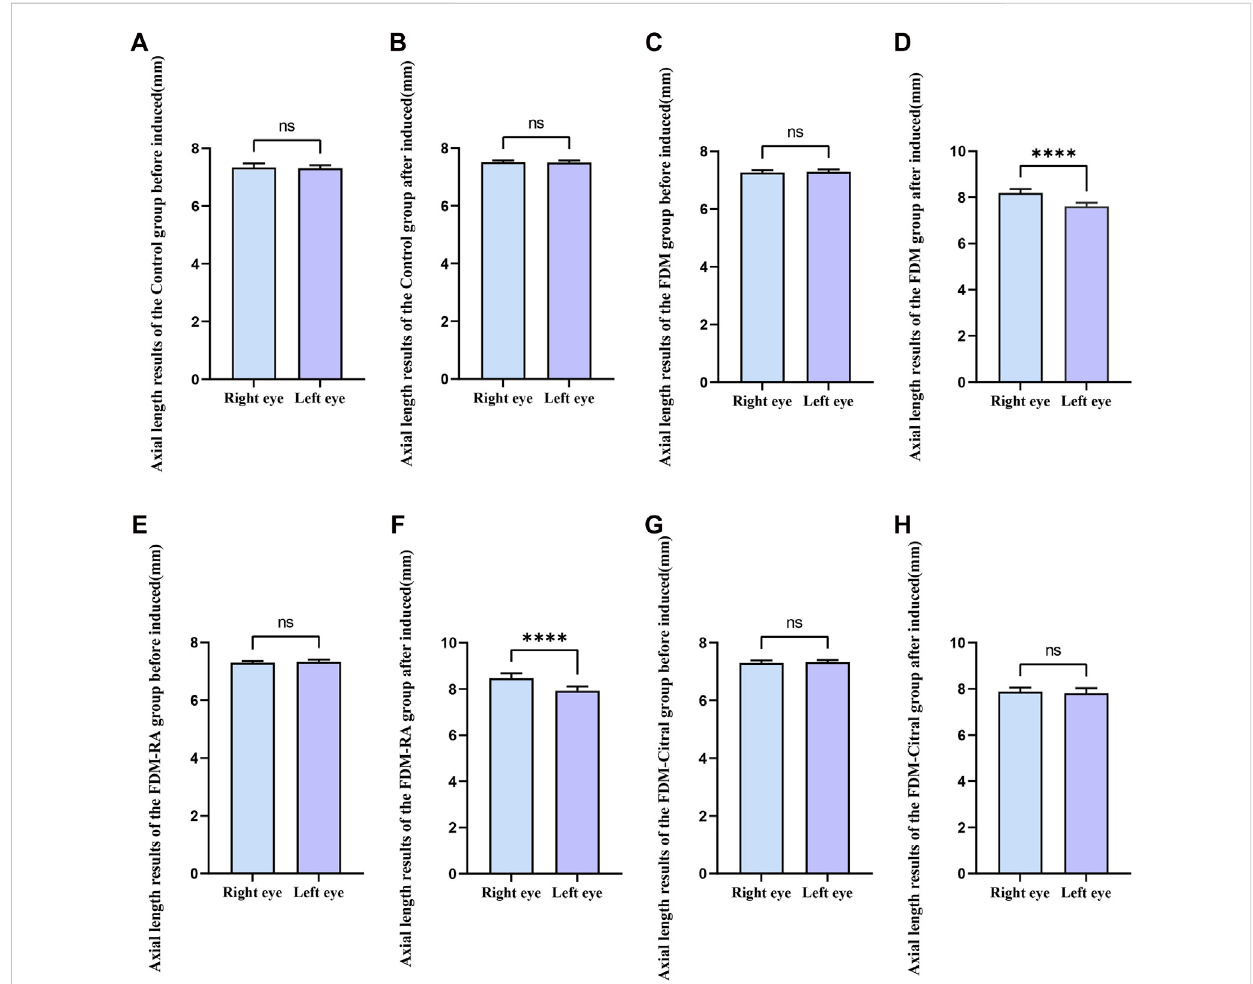
FIGURE 5 Comparison of AL between the left and right eyes in each group (mm). Note. (A) , Comparison of AL between left and right eyes before induction in Control group; (B) , Comparison of AL between left and right eyes after induction in Control group; (C) , Comparison of AL between left and right eyes before induction in FDM group; (D) , Comparison of AL between left and right eyes after induction in FDM group; (E) , Comparison of AL between left and right eyes before induction in FDM + RA group; (F) , Comparison of AL between left and right eyes after induction in FDM + RA group; (G) , ComparisonofALbetweenleftandrighteyesbeforeinductioninFDM+Citralgroup; (H) ,ComparisonofALbetweenleftandrighteyesafterinductionin FDM + Citral group; AL, axial length; ns means that the difference is not statistically signi fi cant; **** Indicates p ≤ 0.0001.